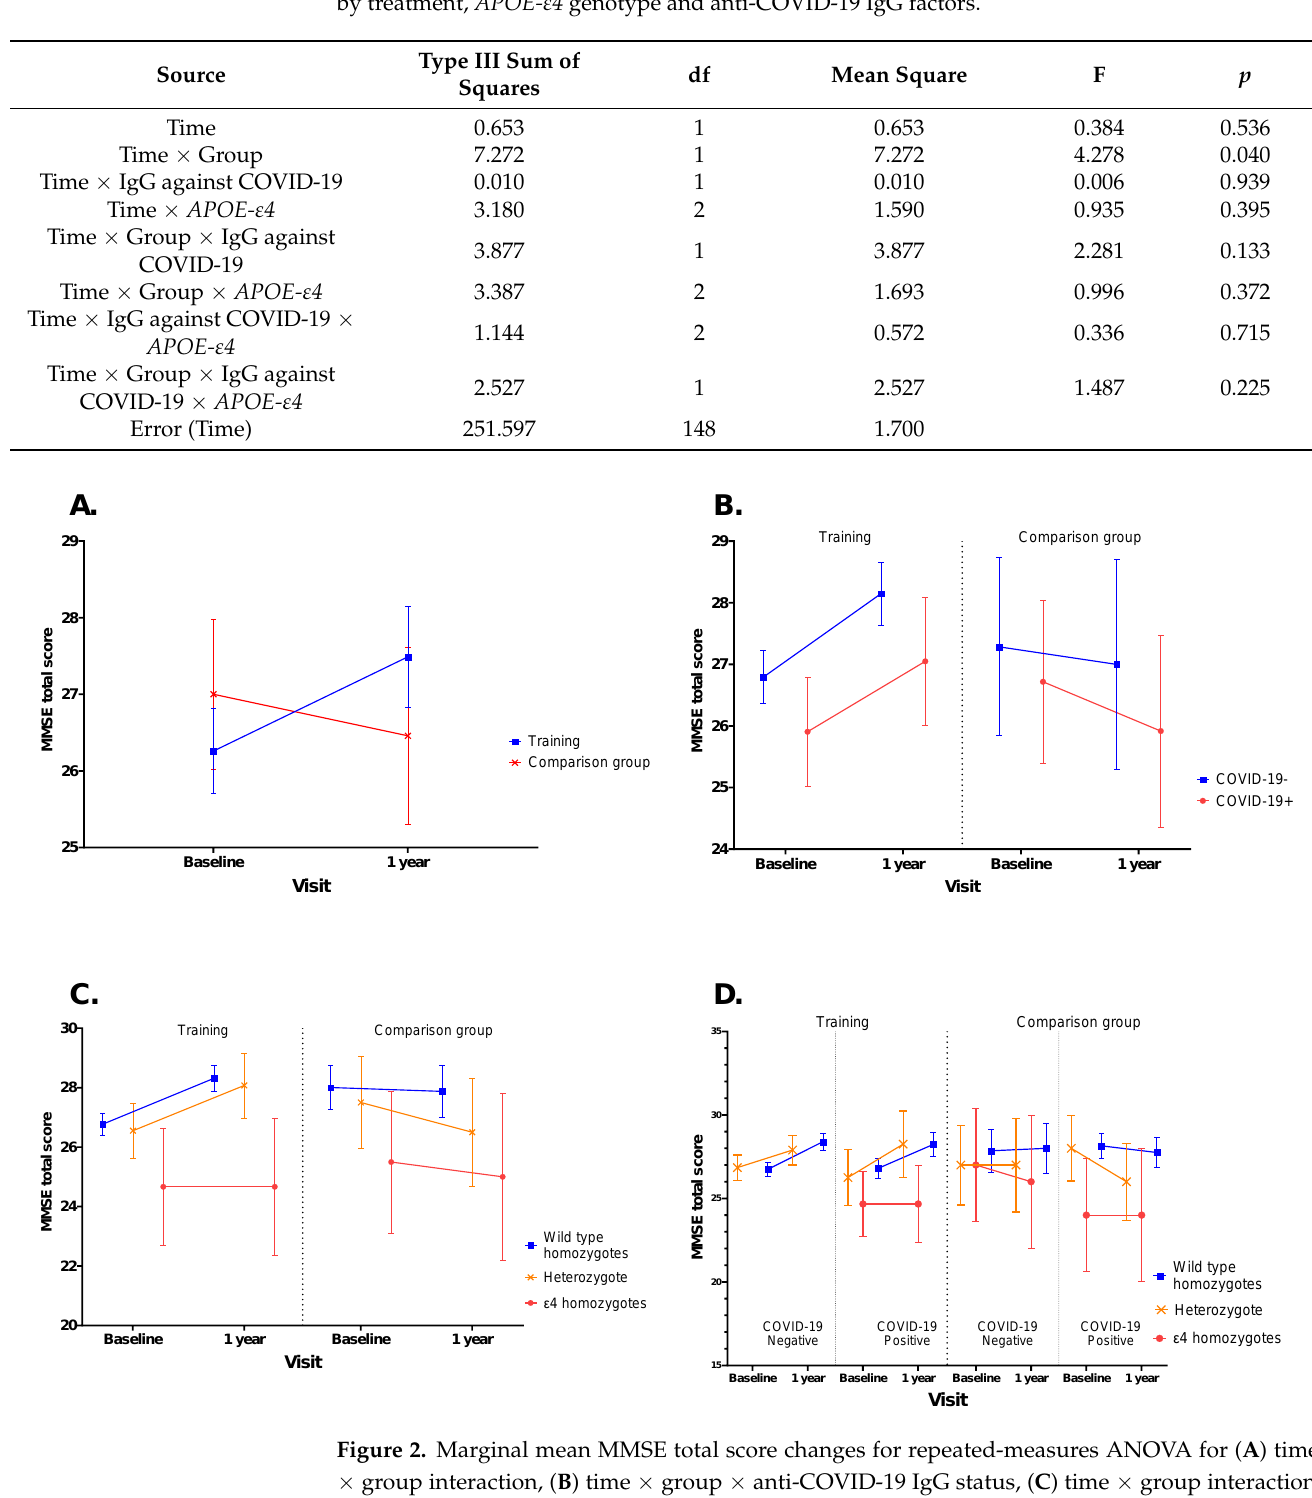
Table 3. Results of repeated-measures ANOVA of MMSE total score changes from baseline to 1 year by treatment, APOE- ε 4 genotype and anti-COVID-19 IgG factors.